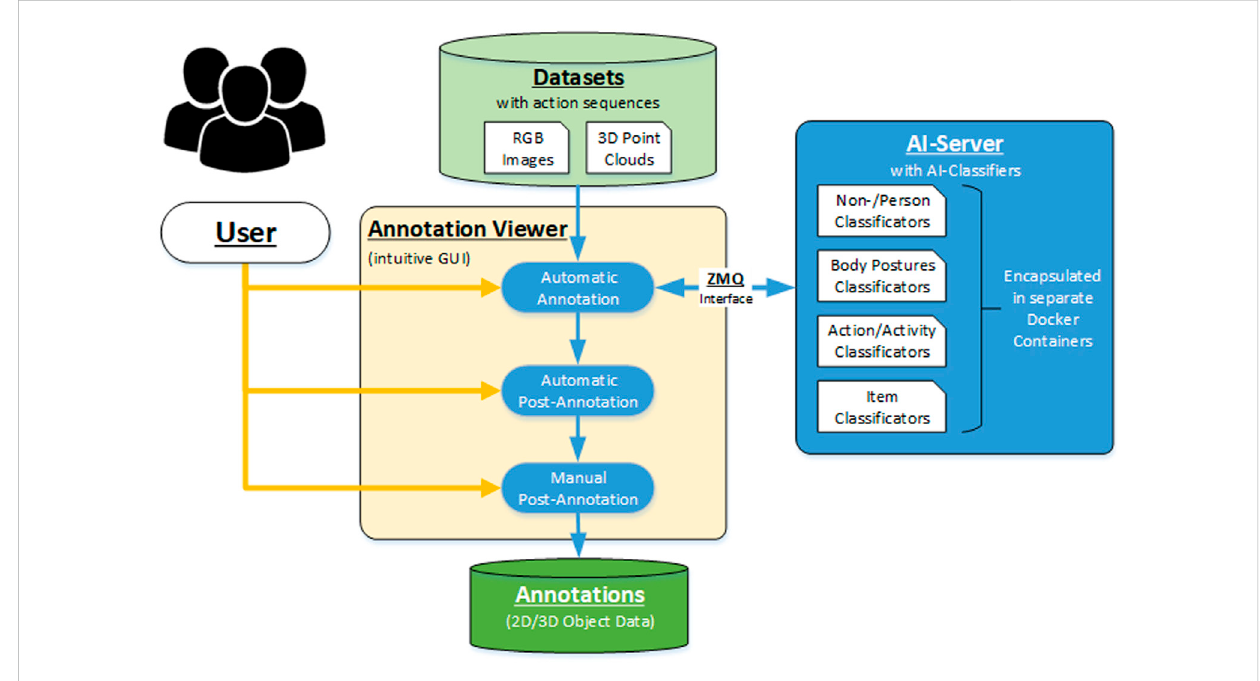
FIGURE 1 Schematic chart of the annotation framework.